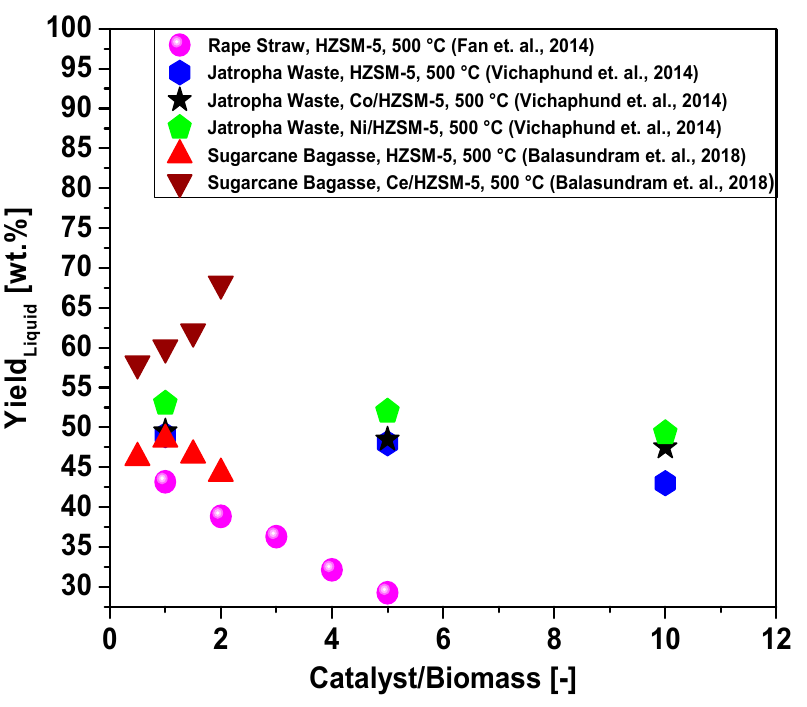
Figure 12. Effect of catalyst-to-biomass ratio within the range 0.5–10.0 on the yield of bio-oil obtained through the upgrading process, compared with similar studies in the literature [8,15,25].